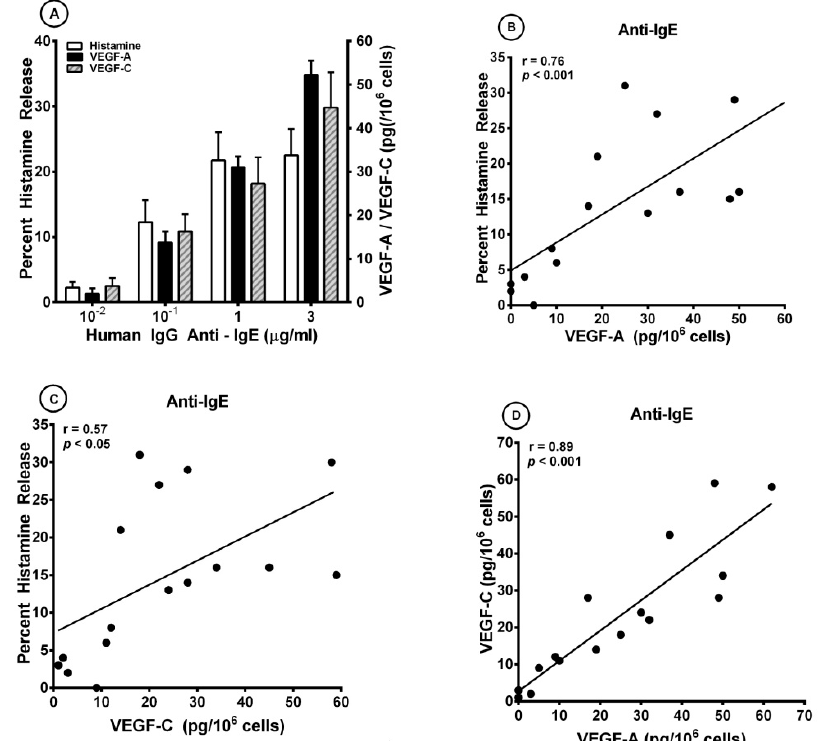
Figure 1. ( A ) Effects of increasing concentrations of human IgG anti-IgE purified from the serum of an atopic dermatitis patient [85,95] on histamine release and the production of VEGF-A and VEGF-C from four different preparations of human lung mast cells (HLMCs). HLMCs were incubated (45 min at 37 ◦ C) with the indicated concentrations of IgG anti-IgE for histamine secretion or (12 h at 37 ◦ C) for VEGF-A and VEGF-C release. Each bar is the mean ± SEM; ( B ) Correlation (r = 0.76; p < 0.001) between VEGF-A release and the percent histamine secretion caused by human IgG anti-IgE from HLMCs; ( C ) Correlation (r = 0.57; p < 0.05) between VEGF-C release and the percent histamine secretion caused by human IgG anti-IgE from HLMCs; ( D ) Correlation (r = 0.89; p < 0.001) between VEGF-A and VEGF-C release caused by human IgG anti-IgE from HLMCs. Table 1. Effects of increasing concentrations of monoclonal antibody anti-Fc ε RI on histamine release and the production of VEGF-A (angiogenic) and VEGF-C (lymphangiogenic) from human lung mast cells.